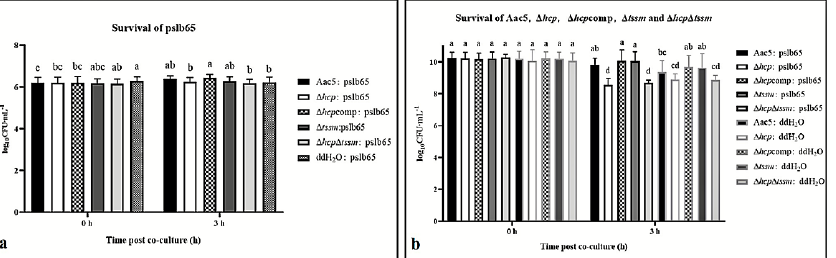
Figure 6. Intraspecies competition between Acidovorax citrulli group I strain pslb65-pBBRMCS5 and group II strains Aac5, ∆ hcp , ∆ hcp comp, ∆ tssm , and ∆ hcp ∆ tssm . ( a ) Survival of